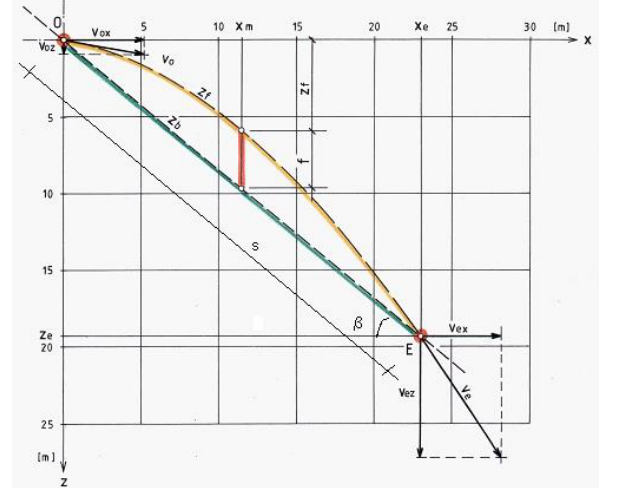
Table 3. Start and end velocities of a parabolic trajectory for differ-